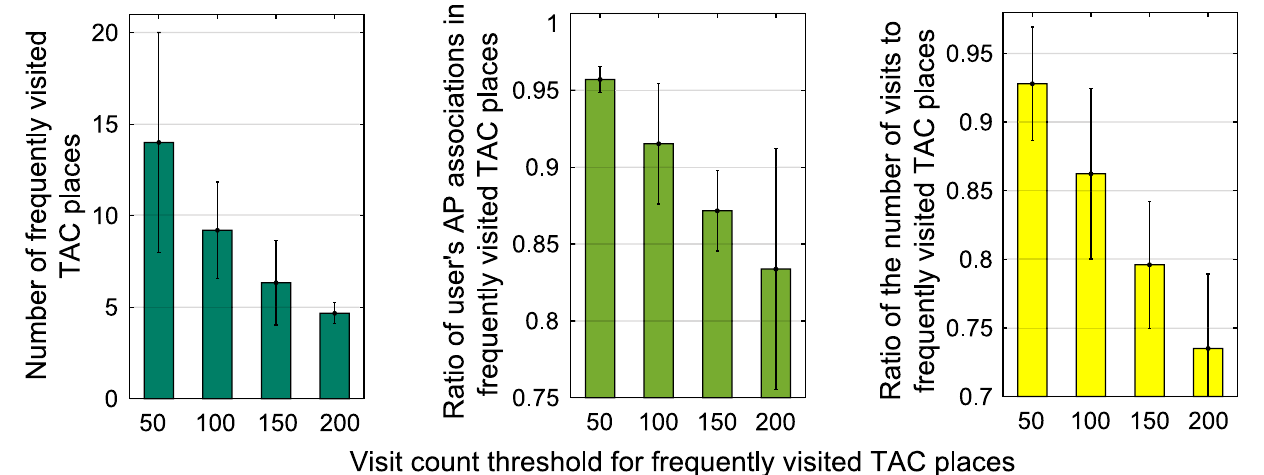
Fig 5. User mobility and WLAN connectivity. (a) the number of frequently visited TAC places and (b) the ratio of AP associations and (c) visits that a user did in the frequently visited TAC places.